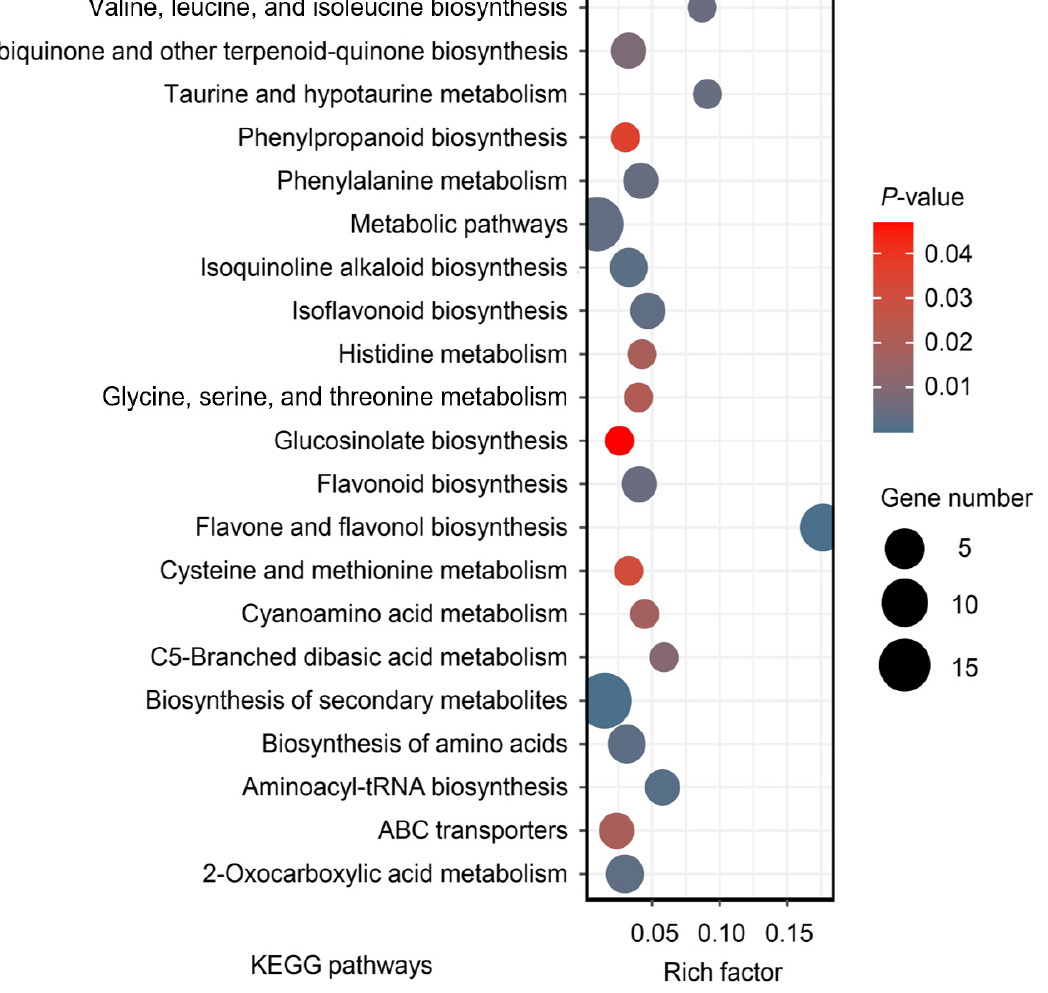
Figure 6. Enrichment analysis of DAMs between CX and LX based on Kyoto Encyclopedia of Genes and Genomes (KEGG).